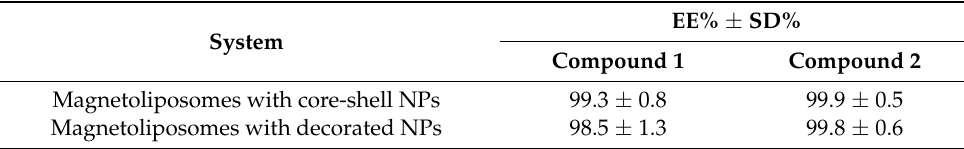
Table 7. Encapsulation efficiencies (EE%) of antitumor compounds 1 and 2 . SD is the standard deviation of three independent